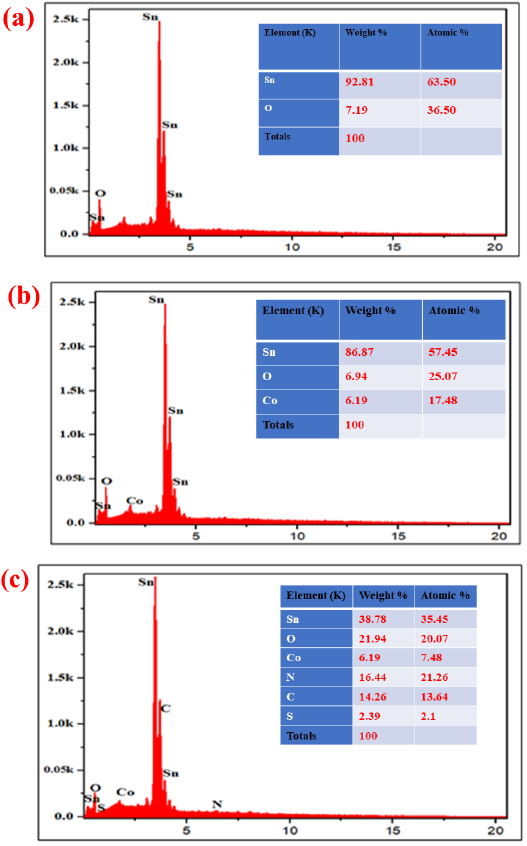
Figure 2. EDX images of SnO 2 ( a ), Co-SnO 2 NPs ( b ), and Co-SnO 2 /SGCN NCs ( c